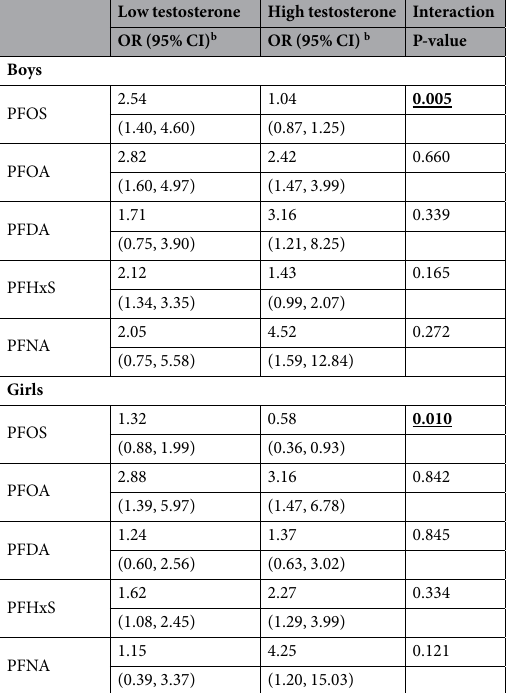
Low testosterone High testosterone Interaction OR (95% CI) b OR (95% CI) b